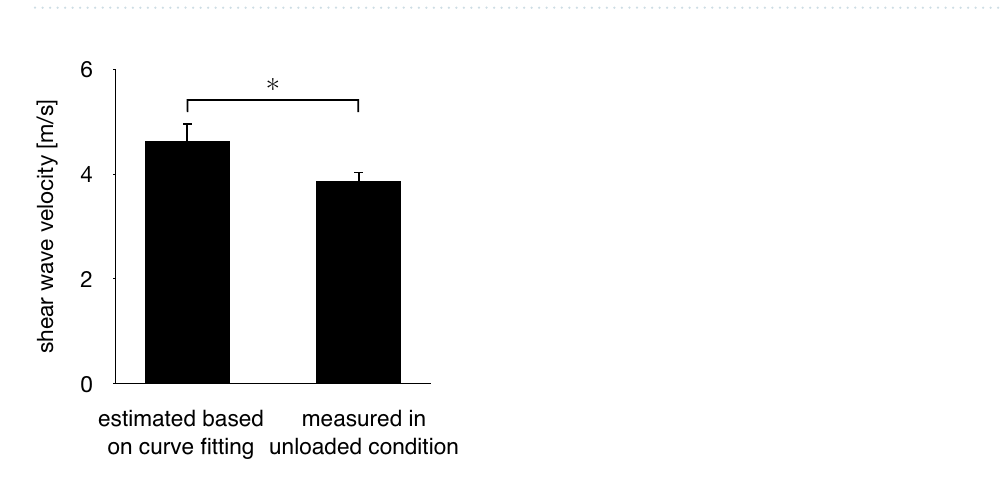
Figure 9. Comparison between the estimated SWV for the natural length of the PA (value of c ) and the SWV in the unloaded condition. The error bars indicate standard deviations. The asterisk indicates that there was a significant